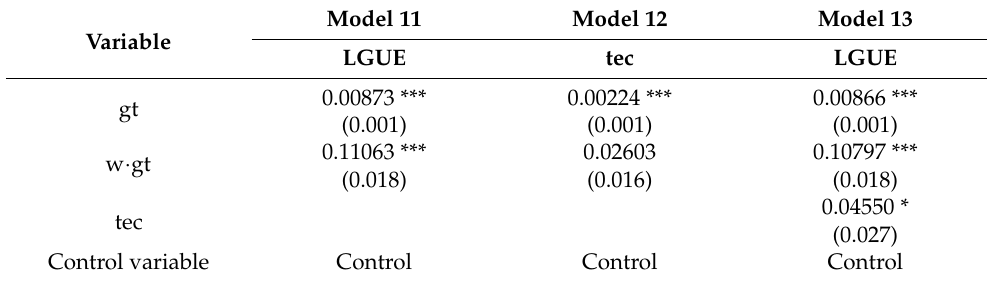
Table 7. Mechanism test results (Innovation inputs).